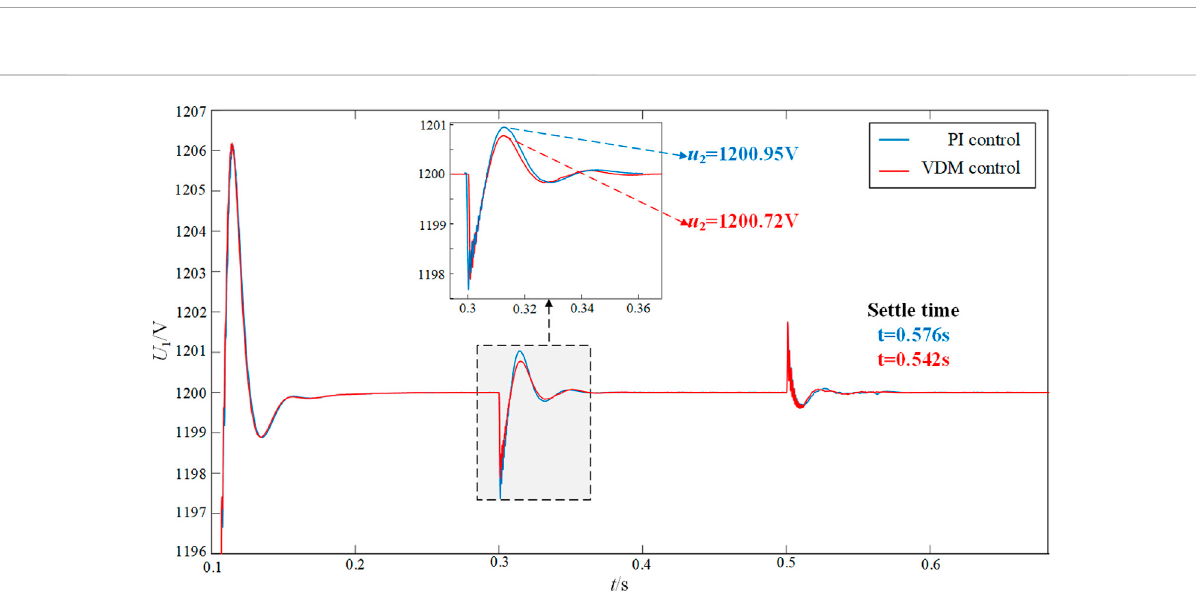
FIGURE 10 Comparison diagram of DC bus voltage under CPL load step